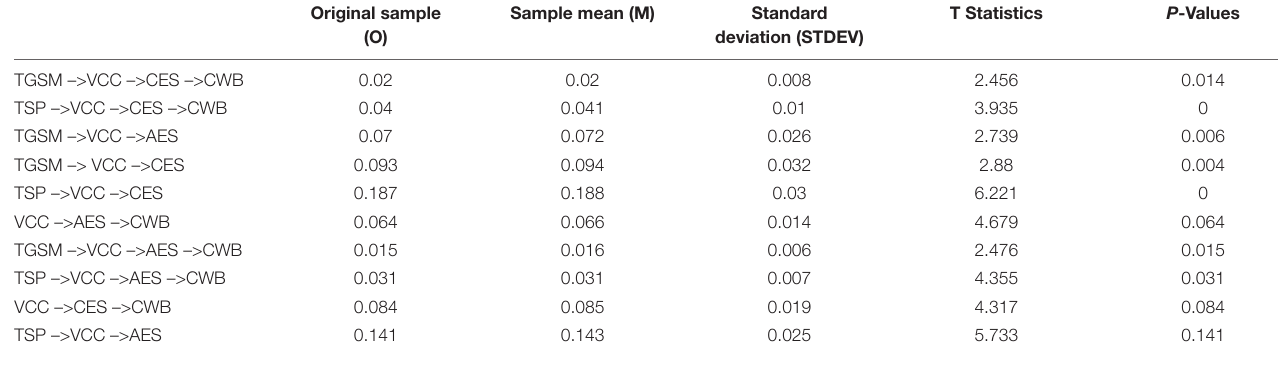
TABLE 7 | Mediation analysis